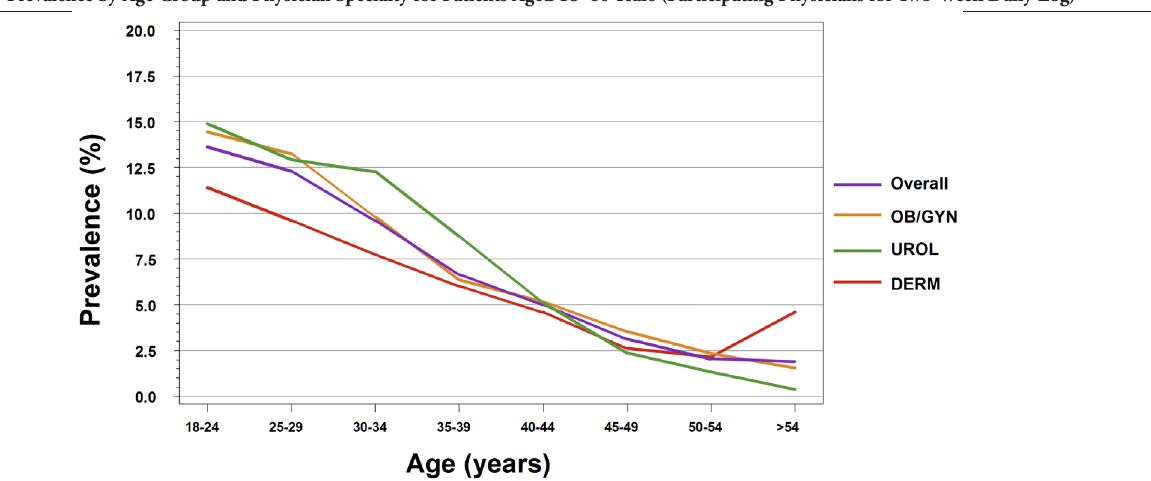
Figure 2. GW Prevalence by Age Group and Physician Specialty for Patients Aged 18–60 Years (Participating Physicians for Two-Week Daily